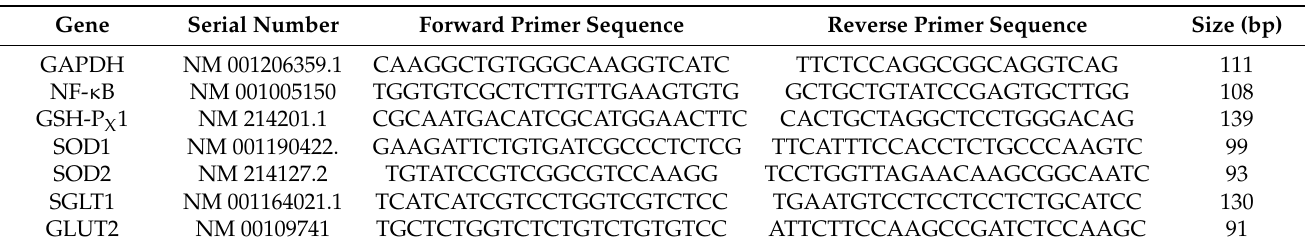
Table 1. Fluorescence quantitative PCR gene primer